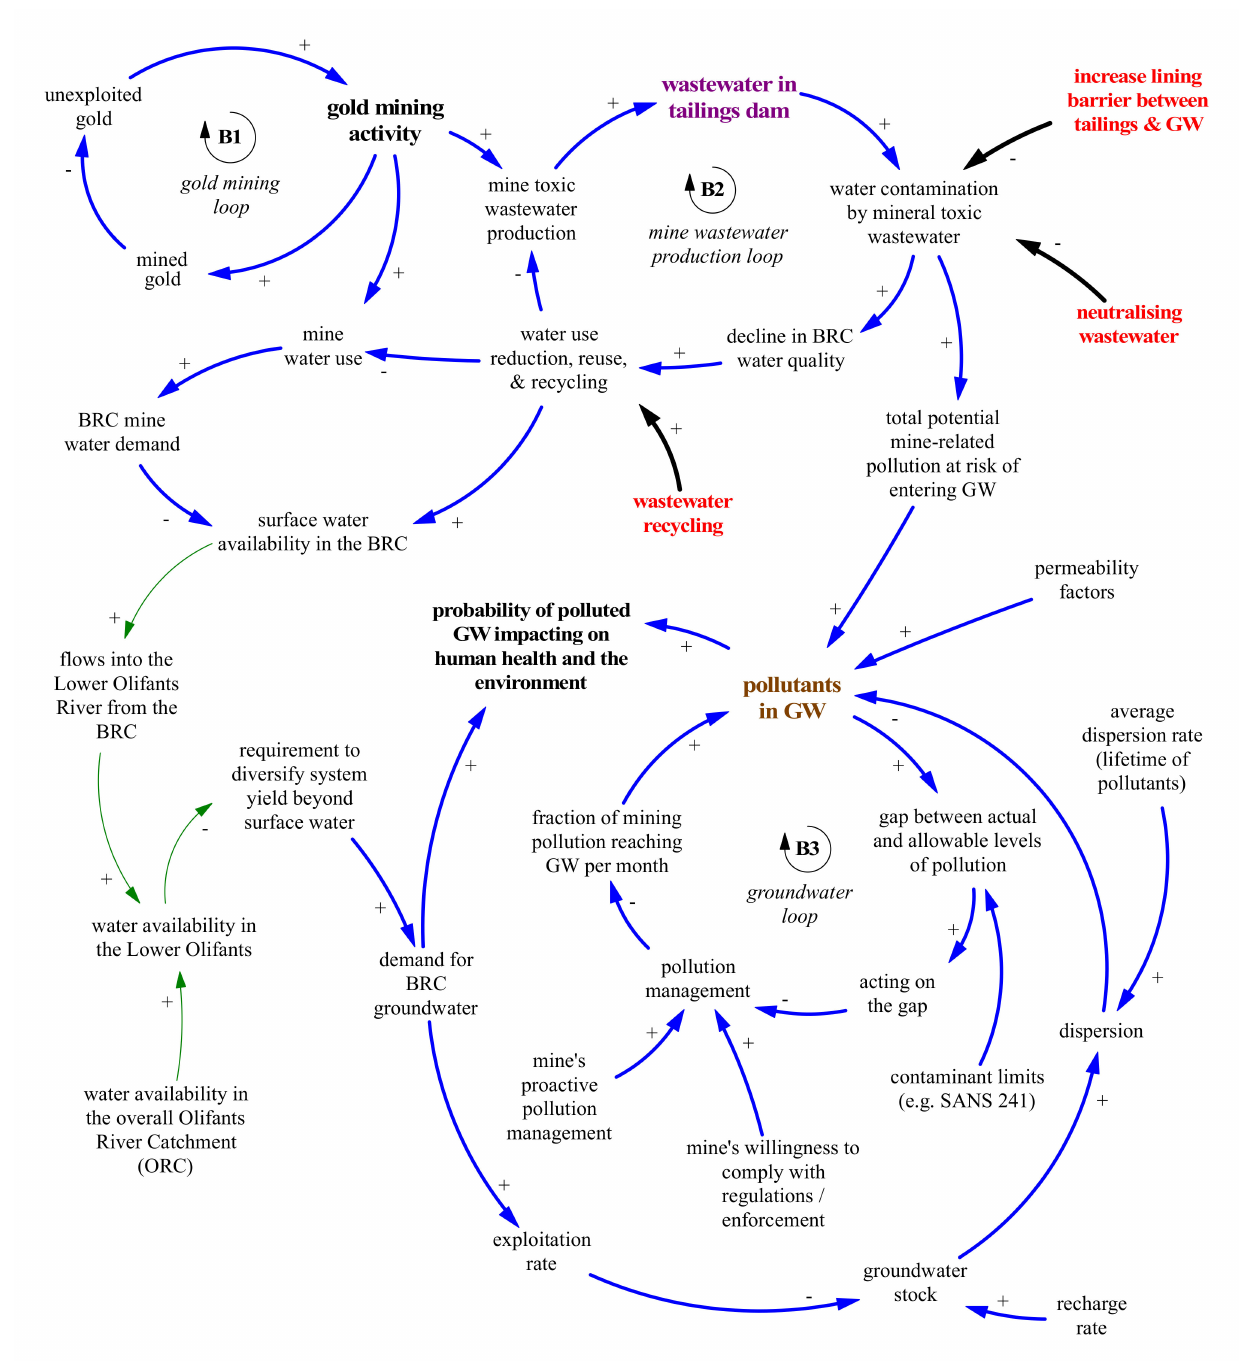
Figure 2. Causal loop diagram (CLD) showing the overall problem conceptualisation and the system boundary. Arrows connect two or more variables of interest and are causal links that run in the stated direction. ‘+’ = a positive relationship, indicating that the causality runs in the same direction (i.e., an increase in variable A will cause an increase in variable B and vice versa); ‘–’ = a negative relationship, indicating that the causality runs in the opposite direction (i.e., an increase in variable A will cause a decrease in variable B and vice versa). The variables connected by the thin green arrows pertain to surface water management and are conceptually included in the rationale for groundwater resource development, but surface water is not empirically modelled in the simulation model. The balancing feedback loops are numbered Bn and labelled. The variables in red font with black arrows show select intervention points in the system. BRC = Blyde River Canyon; GW =